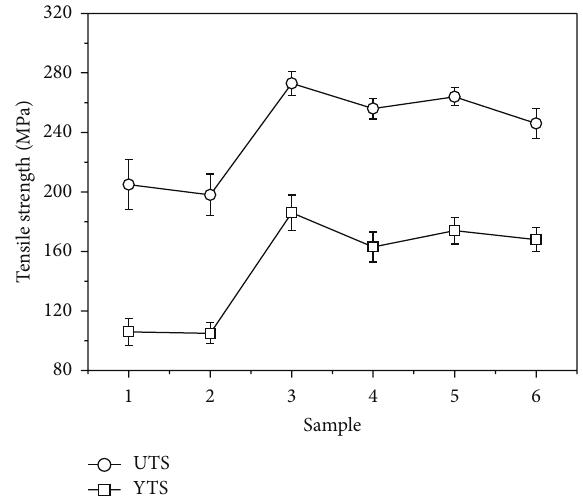
Figure 8: The tensile strength of samples containing different main participate